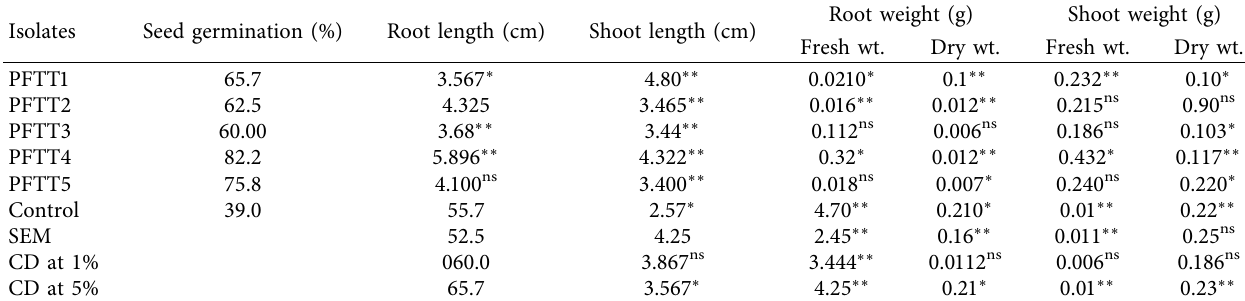
Figure 1: Plant growth promoting activities of Pseudomonas fluorescens. Table 3: Pseudomonas fluorescens effect on seed germination and vegetative growth of okra.